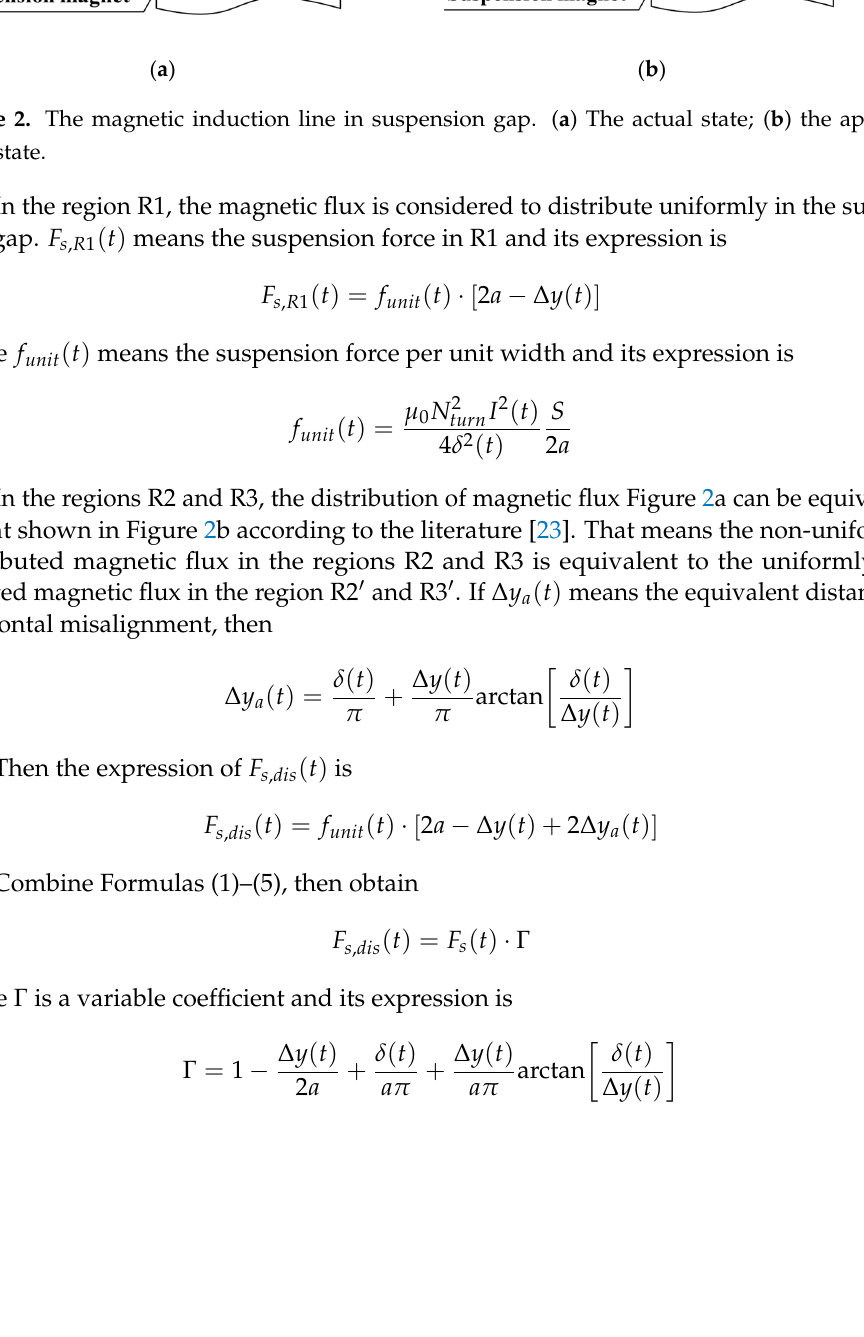
Figure 2. The magnetic induction line in suspension gap. ( a ) The actual state; ( b ) the approximate state.